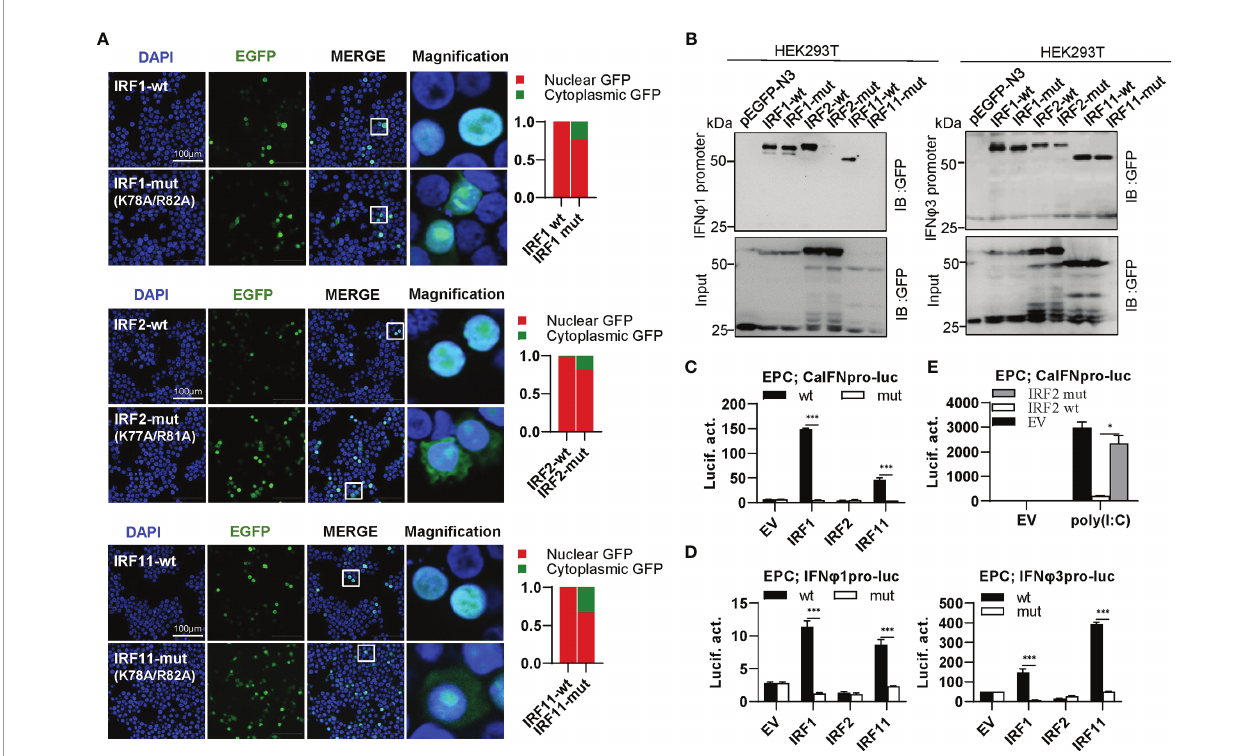
FIGURE 6 | The two basic residues are essential for IRF1/2/11 to regulate IFN response. (A) Mutation of the two basic residues impaired the constitutively nuclear accumulation of IRF1/2/11. Left panels: HEK293T cells seeded overnight on microscope slide cover-glasses in six-well plates were transiently transfected as in Figure 4 , with indicated IRF plasmids (2 m g each) for 24h, followed by confocal microscopy examination. The last column showed magni fi cation view of the area highlighted in the box. Right panels: The intensities of nucleus/cytoplasm GFP were quantitated using the ImageJ processing program and normalized to that of the empty construct pEGFP-N3, which was set to 1:1. (B) Pull-down analysis of the binding af fi nity of IRF1/2/11 wild types and IRF1/2/11 mutants to IFN j 1/IFN j 3 promoters. DNA pull-down assays were performed as in Figure 3B , by incubating biotin-labeled IFN j 1 or IFN j 3 promoter DNAs with appropriate amounts of HEK293T cell lysates, where cells were transfected for 30h with wild types or mutants of IRF1/2/11, respectively. (C, D) IRF1/11 mutants failed to stimulate the activation of crucian carp IFN promoter (C) , and zebra fi sh IFN j 1/IFN j 3 promoters (D) . EPC cells seeded in 48-well plates overnight were transfected with CaIFNpro- luc (C) , IFN j 1pro-luc or IFN j 3pro-luc (D) , together with the indicated IRF plasmids (100ng each) for 30 h, followed by luciferase assays. (E) IRF2 mutant failed to inhibit poly(I:C)-triggered activation of crucian carp IFN promoter by luciferase assays. EPC cells were transfected with the indicated plasmids (100ng each), together with poly(I:C) (1 m g/ml) for 30h. (***P < 0.001, *P <